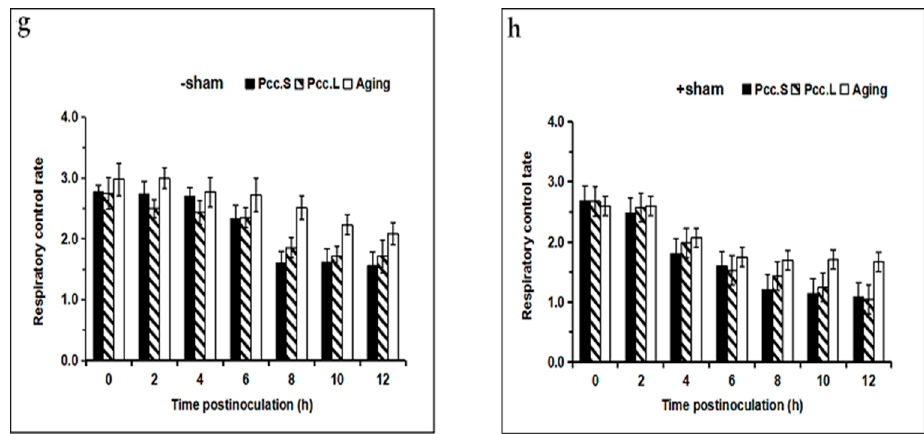
Figure 5. Effect of Pcc .L and Pcc .S treatment on mitochondrial endogenous respiration, mitochondrial state 3, state 4 and the relative control rate of tuber slices in the no salicylhydroxamic acid treated group ( a , c , e , g ) and those of the salicylhydroxamic acid pretreated group ( b , d , f , h ). Aging indicates naturally aged potato tuber slices as control. Bars with * ( t- test) were significantly different at p < 0.05 between Pcc .S and Pcc .L. The standard errors (Vertical bars) of three replicates are shown.